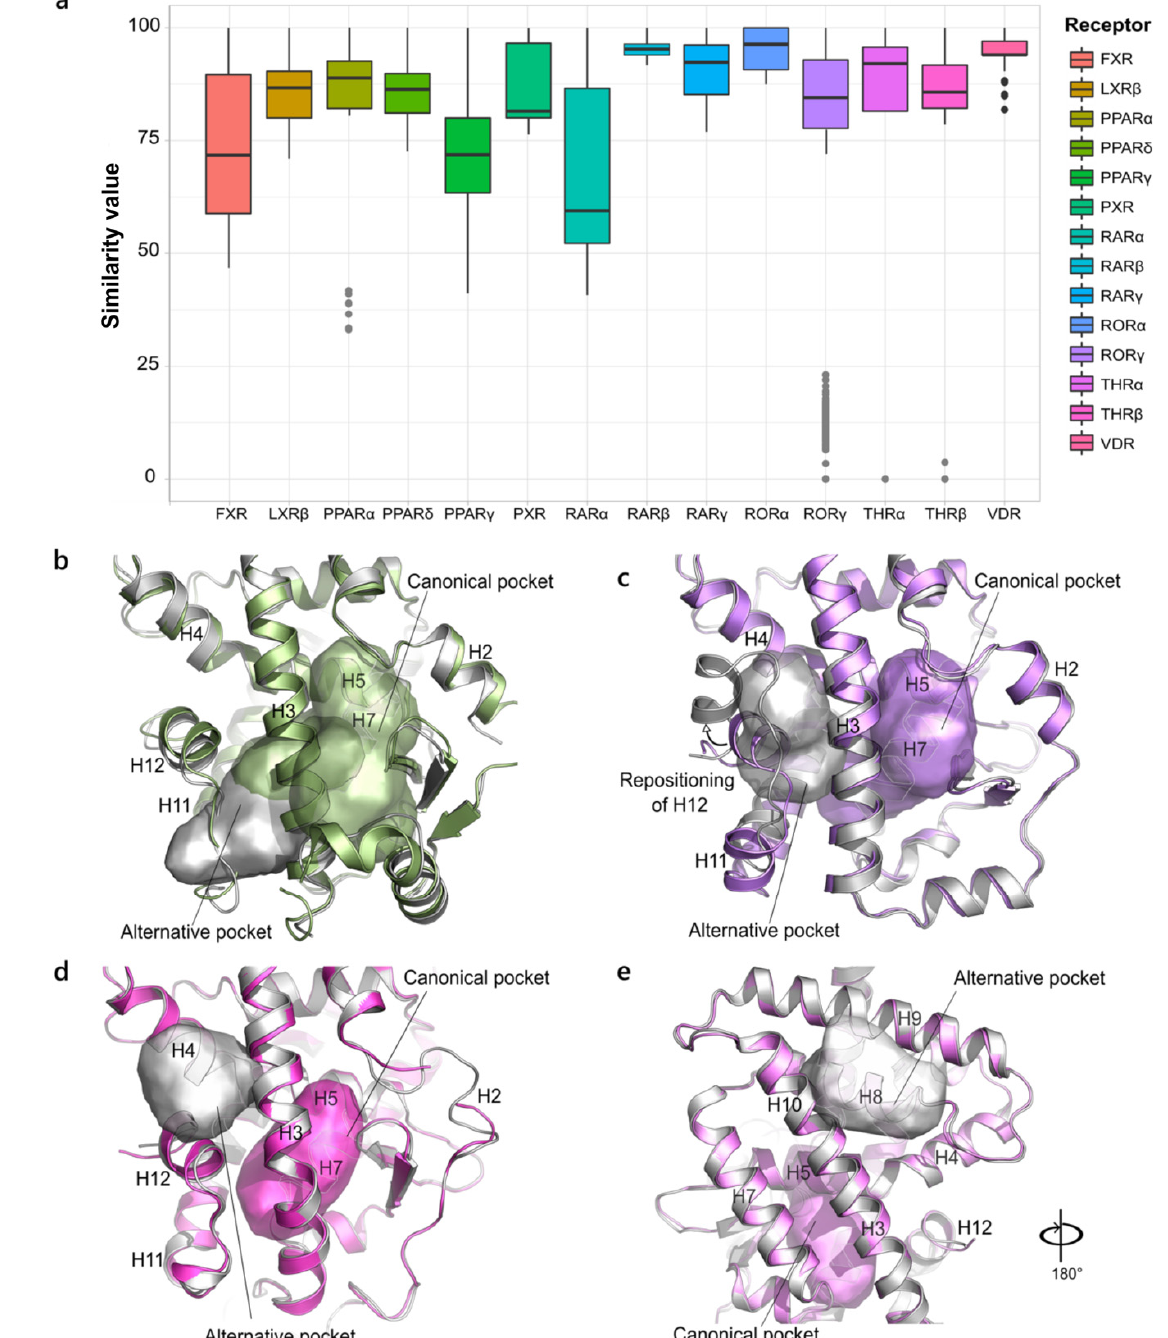
Figure 1. Variability in NR1 family. ( a ). Boxplot representing the structural variability in the LBD binding site in the NR1 family. The outlier points corresponding to non-canonical binding pockets are highlighted in grey. ( b ). Superposition of the canonical active pocket (green, PDB ID 2P54) and the outlier one (grey, PDB ID 5HYK) in PPAR α . The two pockets are intersected, as they share some of the residues in helices H3, H5 and H7. ( c ) Superposition of the canonical active pocket (lilac, PDB ID 5NIB) and the outlier one (grey, PDB ID 5C4S) in ROR γ . The newly induced orientation of H12 is indicated by an arrow. ( d ) Superposition of the canonical active pocket (magenta, PDB ID 2J4A) and the outlier one (grey, PDB ID 2PIN) in THR β . ( e ) Superposition of the canonical active pocket (violet, PDB ID 2H79) and the outlier one (grey, PDB ID 4NLW) in THR α . In PPAR α , the outlier points correspond to a pocket close to the canonical one but are confined within H3 and H11, in which a smaller and more rigid ligand can be